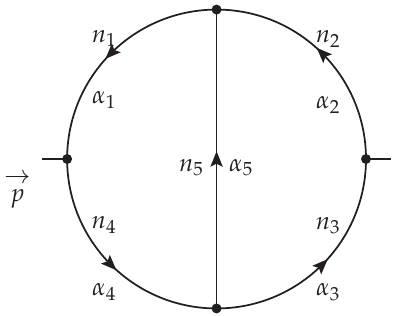
Figure 1. The diagram which cannot be expressed as a combination of loops and